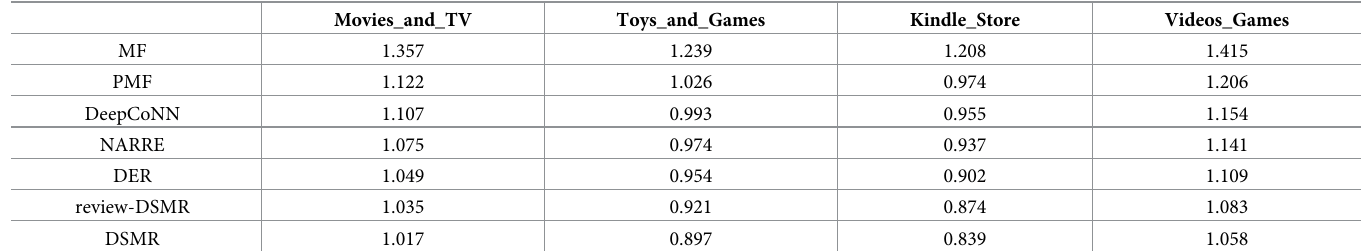
Table 3. Performance comparison with data equalization control (RMSE).